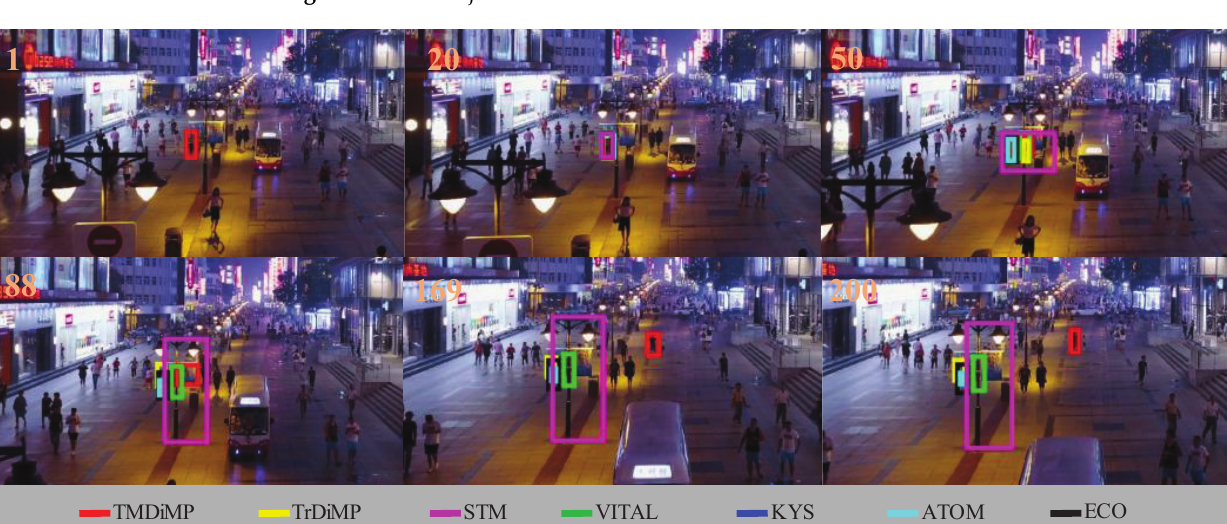
Figure 12. The subjective results in VIPUOTB.